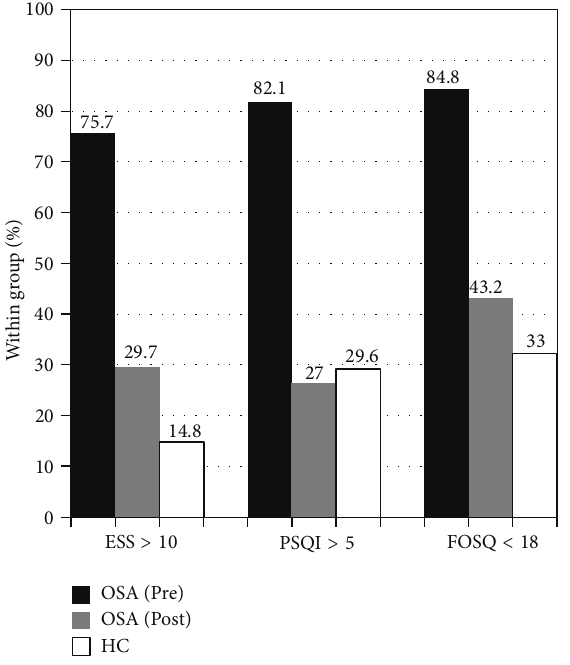
Figure 1: Percentages of participants with OSA pre- and post- treatment and of controls scoring in the clinically significant range on the Epworth Sleepiness Scale (ESS), Pittsburg Sleep Quality Index (PSQI—global score), and Functional Outcomes of Sleep Questionnaire (FOSQ—total score).